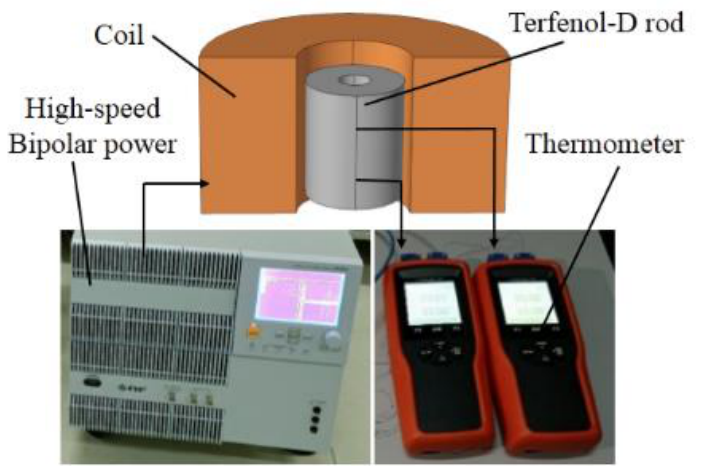
Figure 5. Three structures of Terfenol-D rods for experiment.